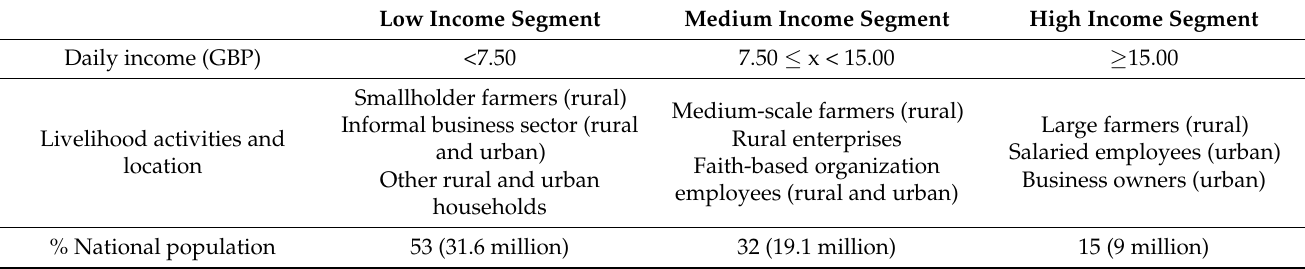
Table 2. Segmentation of end-users.